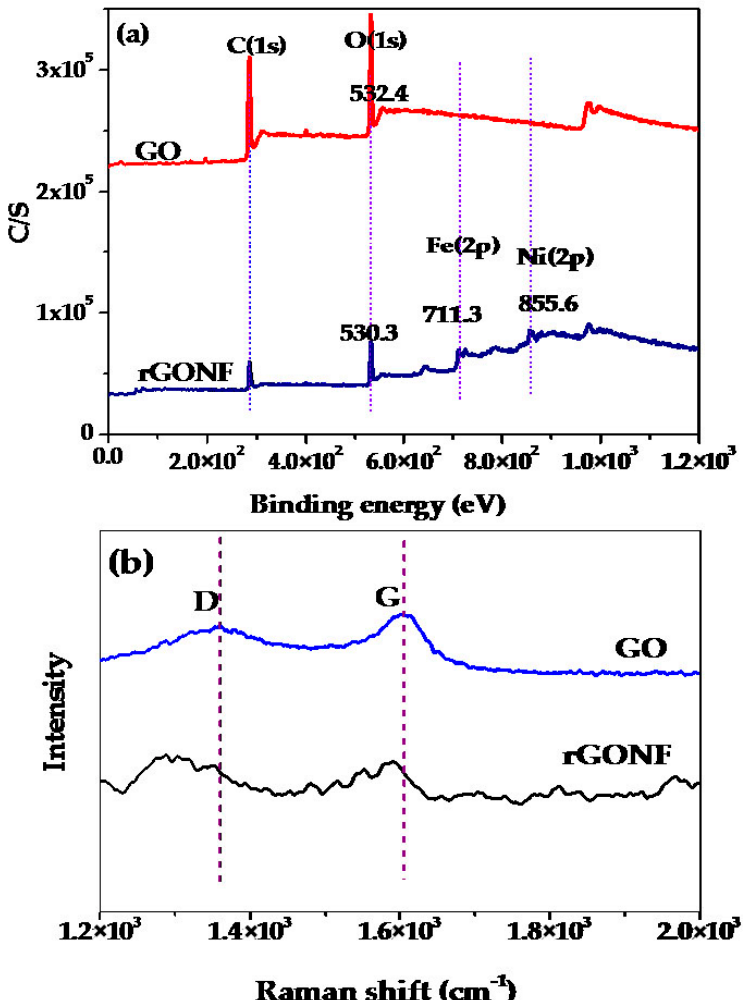
Figure 1. X-ray photoelectron spectroscopy (XPS) ( a ) and Raman spectral ( b ) analysis of rGONF. (Doted lines in the figure indicates the peaks comparison).